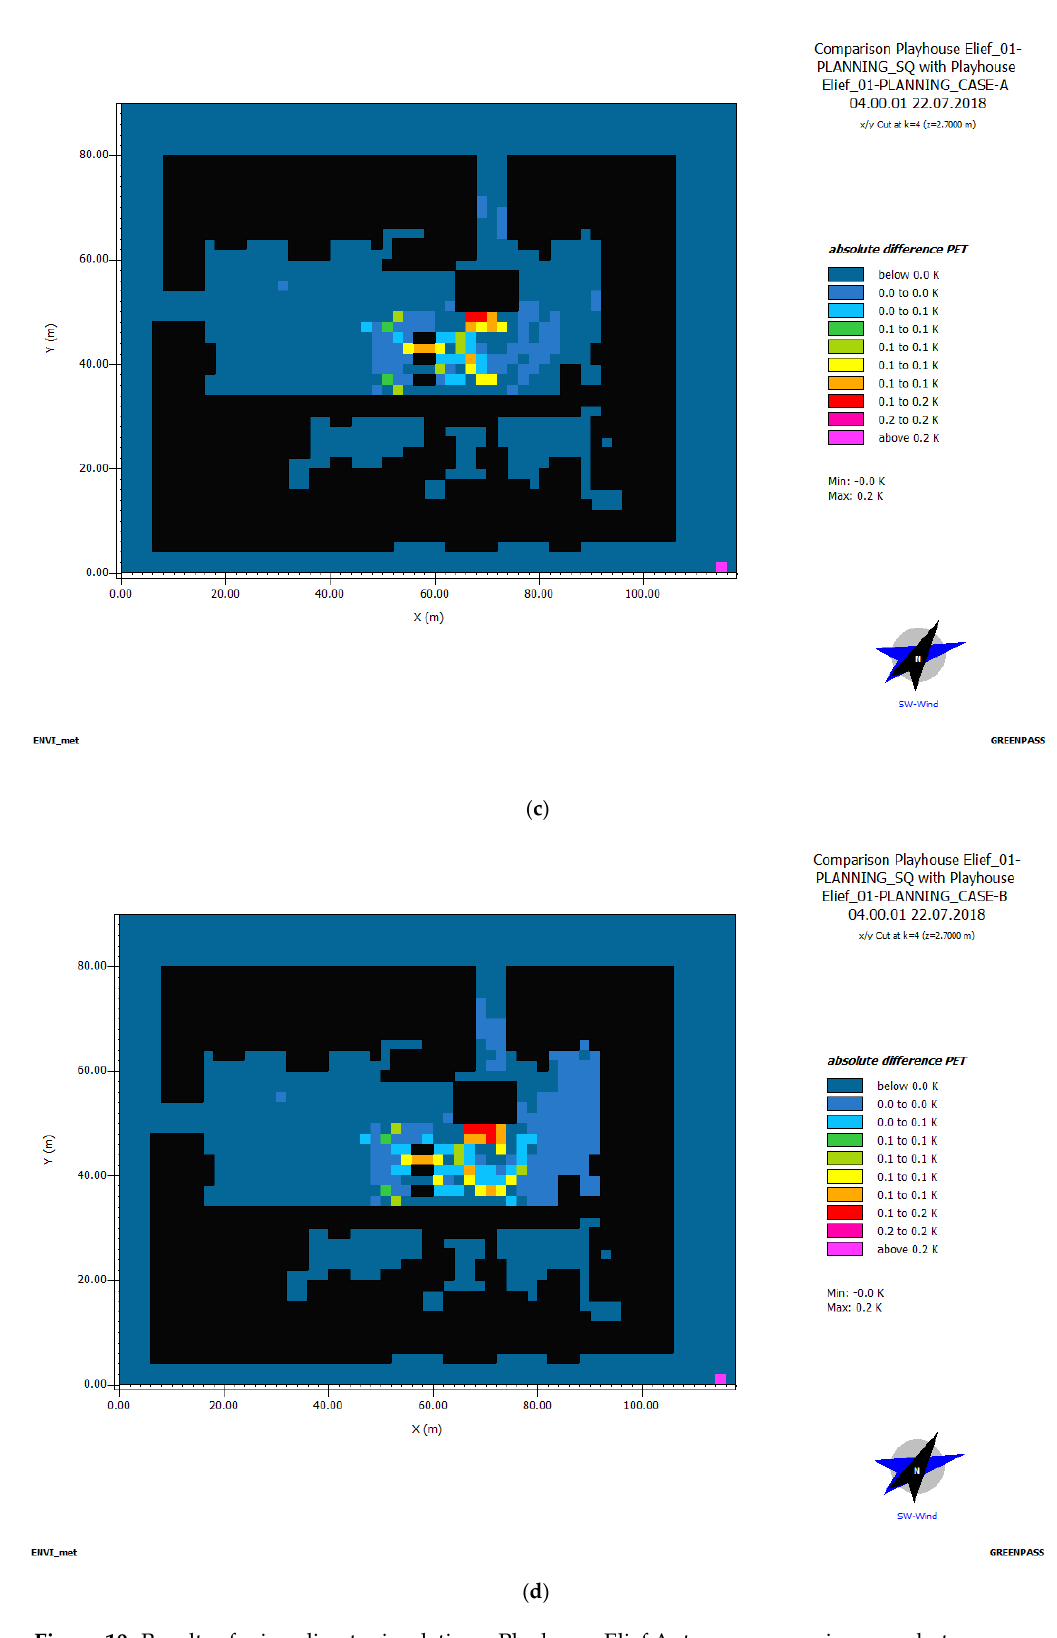
Figure 10. Results of microclimate simulation—Playhouse Elief Antwerp, comparison on a hot summer day 21.07. ( a ) Variant SQ—air temperature 04:00 at roof level; ( b ) Variant B—air temperature 04:00 at roof level; ( c ) Variant A—PET 04:00 at roof level; ( d ) Variant BPET 04:00 at roof level.